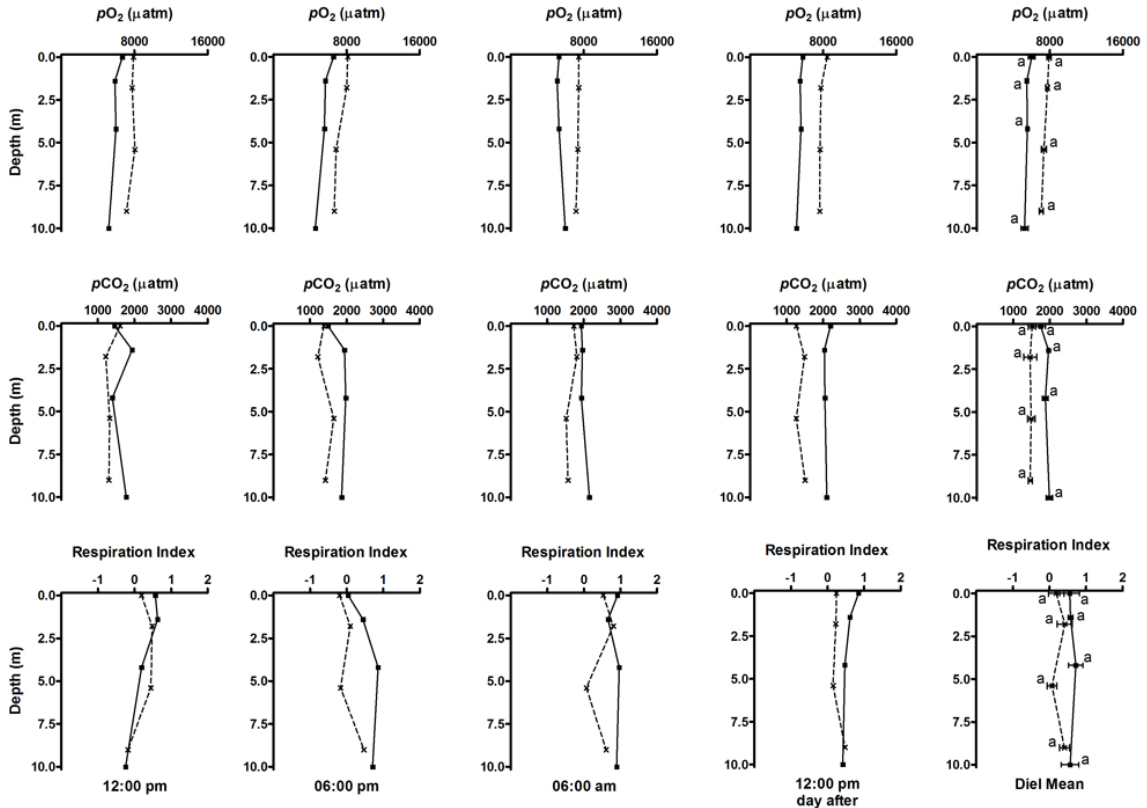
Fig. 5. Vertical profiles of daytime p O 2 , p CO 2 and respiration index from the lake surface to deep waters for both lakes during a thermal mixing event in the dry winter (June 2005). Values are the average ± SE. Symbols and letters are as defined in Fig.